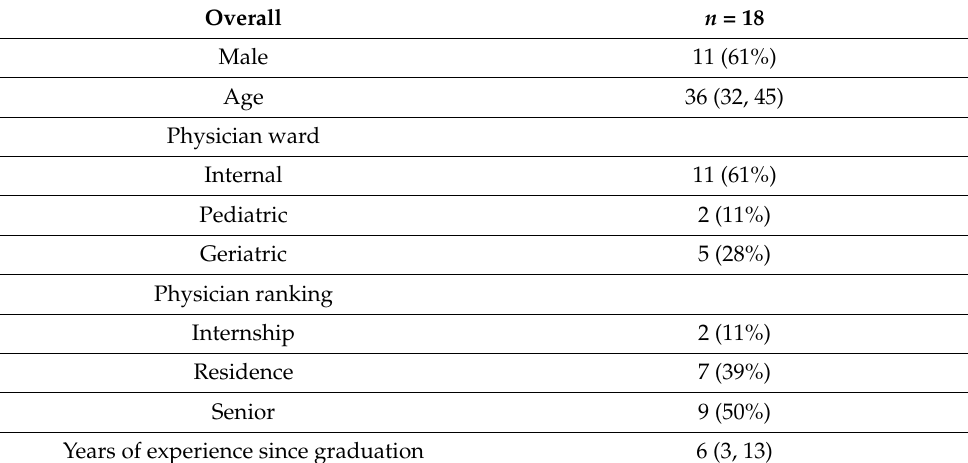
Table 1. Characteristics of physicians participating in this